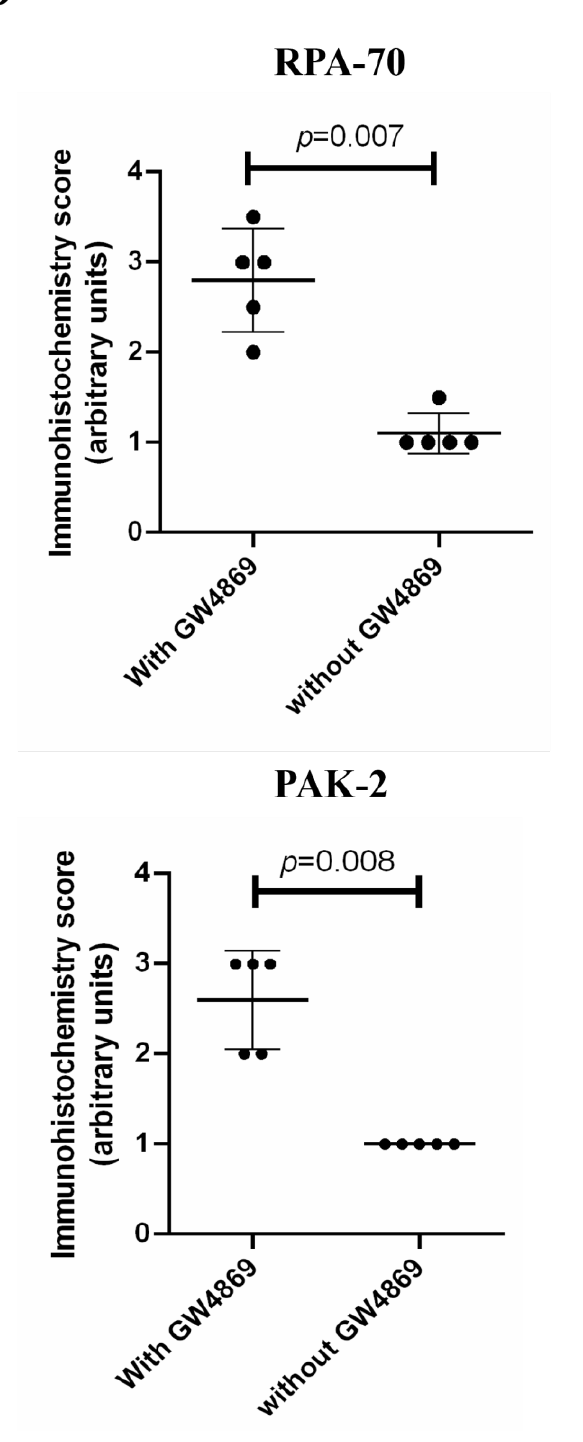
Figure 7. The representative immunohistochemistry images showing the expression of RPA-70 ( A ), PSME-4 ( B ), and PAK-2 ( C ) in missed-miscarriage placental explants that had been treated with ( a ) or without ( b ) GW4869, measured by a semiquantitative analysis ( D ) (magnification: ×400).